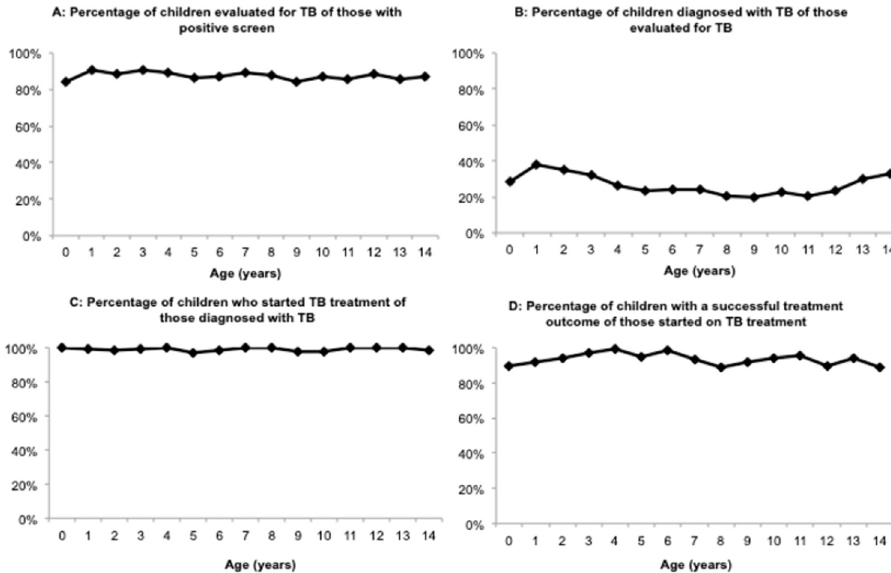
Fig 3. Percentage of children completing each step of the care cascade, by